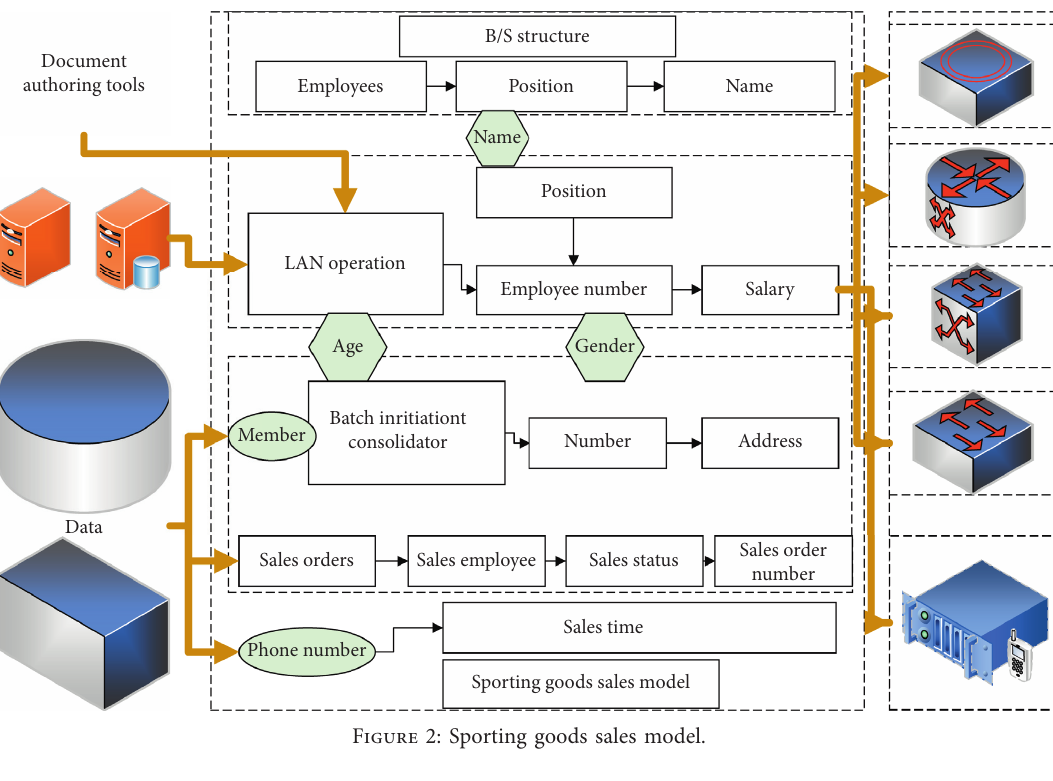
Figure 2: Sporting goods sales